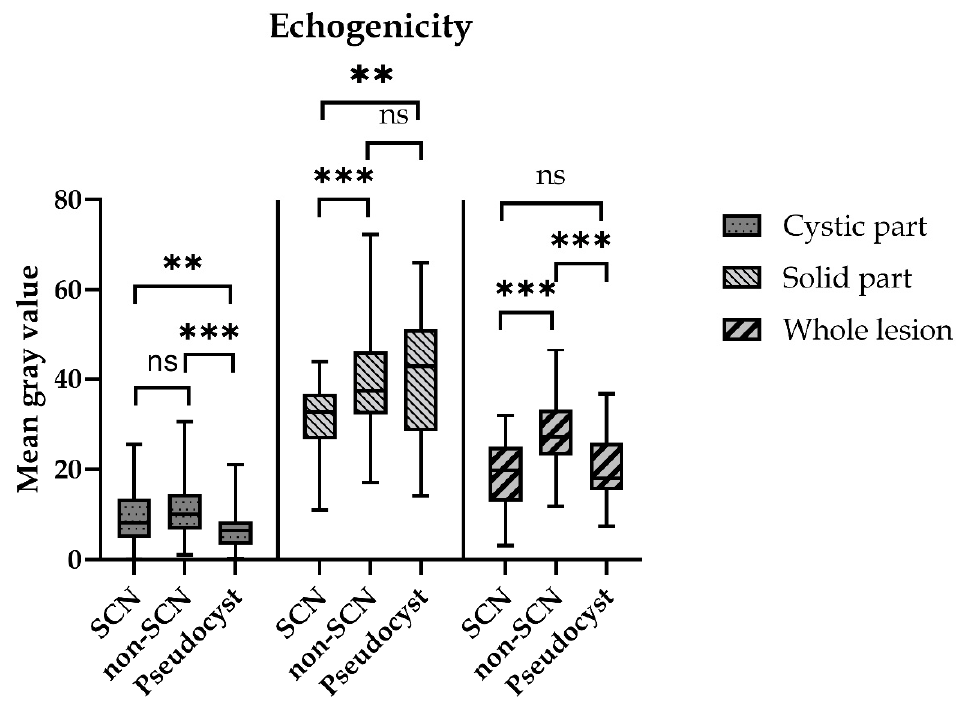
Figure 4. Mean gray values of the different parts of cystic lesions. Based on the echogenicity, the lesions were transformed into a matrix of values and the average gray value of the areas was determined by the software. (ns = non-significant; ** p < 0.005; *** p < 0.0005) . The inhomogeneity value of the whole lesion was 16.6 ± 0.7 in the SCN, 22.3 ± 0.6 in the Non-SCN and 22.6 ± 0.8 in the Pseudocyst group. The inhomogeneity value was sig- nificantly higher in the Non-SCN ( p < 0.0005) and in the Pseudocyst ( p < 0.0005) groups than in the SCN group. There was no significant difference between the Non-SCN and the Pseudocyst groups. There was no significant difference between the inhomogeneity of the cystic parts, the values were 7.1 ± 0.7, 6.9 ± 0.3 and 7.1 ± 0.6, respectively, in the SCN, Non- SCN and Pseudocyst groups. However, the solid parts’ inhomogeneity was significantly higher in the Non-SCN (21.1 ±0.6; p < 0.0005) and in the Pseudocyst (24.3 ± 1.1; p < 0.0005) groups than in the SCN (16.1 ± 0.7) group. The calculated value was significantly higher in the Pseudocyst group compared with the Non-SCN group ( p = 0.017) (Figure 5). The density of the whole lesions in the SCN, Non-SCN and Pseudocyst groups was 2833.8/mm 2 ± 192.6, 4186.6/mm 2 ± 135.6 and 2981.6/mm 2 ± 144.5, respectively. The density of the Non-SCN group was significantly higher than in the SCN ( p < 0.0005) and the Pseu- docyst ( p < 0.0005) groups. There was no significant difference between the SCN and the Pseudocyst groups. The density of the cystic parts in the SCN, Non-SCN and Pseudocyst groups was 1461.4/mm 2 ± 117.0, 1668.6/mm 2 ± 67.57 and 1127.3/mm 2 ± 107.1, respectively. In the Pseudocyst group, the density was significantly lower than in the SCN ( p = 0.015) and in the Non-SCN ( p < 0.0005) groups. There was no significant difference between the SCN and the Non-SCN groups. The solid parts’ density was highest in the Pseudocyst group (6117.9/mm 2 ± 25.6), while it was lowest in the SCN group (4737.6/mm 2 ± 194.6), meanwhile, in the Non-SCN group it was 5875.0/mm 2 ± 183.0. The density of the SCN’s solid part was significantly lower than in the Non-SCN ( p = 0.0009) and the Pseudocyst ( p < 0.005) groups. There was no significant difference between the Non-SCN and the Pseu- docyst groups (Figure 6).